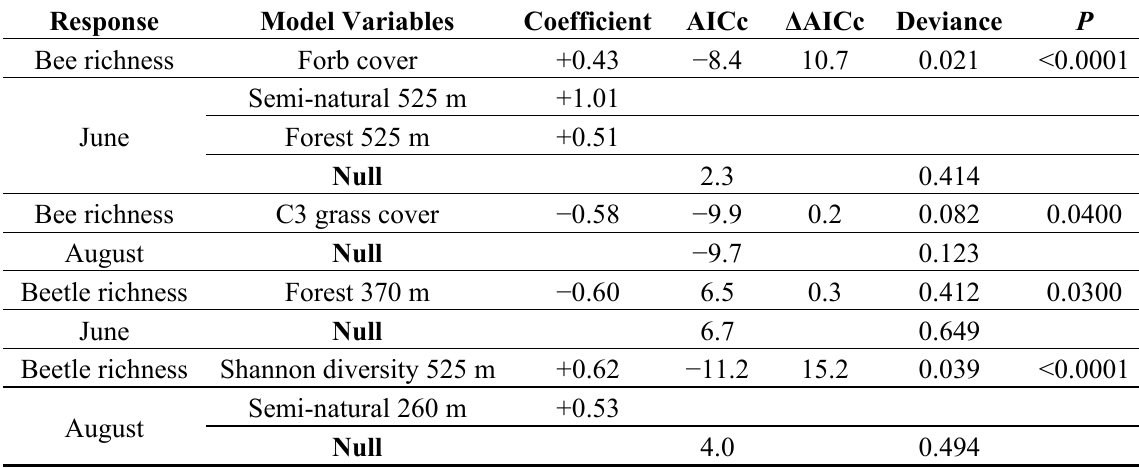
Table 1. Summary of regression results for the effects of vegetation composition and surrounding land cover on the species richness of bees and predatory beetles in 10 conservation grasslands. Standardized regression coefficients are shown. The P -value is the likelihood ratio test of the best-fitting model compared to the null model. Response variables with two sets of AICc and P-values are competing